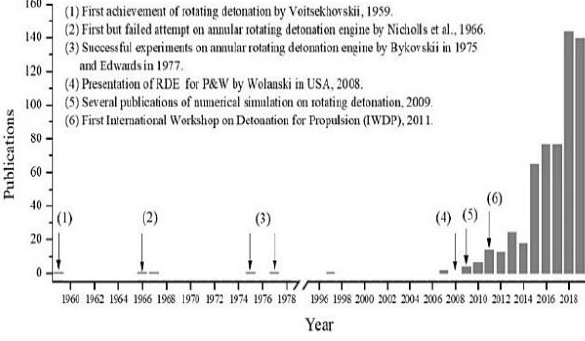
Fig. 1. Graphical illustration of numbers of publication related to RDE research from time of first experimental obtainment of the continuously rotating detonation up to recent time (2019) (Courtesy of Bing Wang)